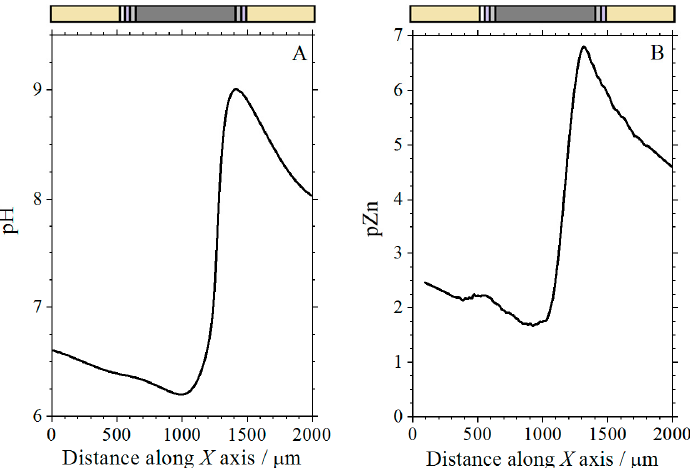
Figure 14. Simultaneous line scans recorded with a double-barrel microelectrode tip containing a pH-sensitive antimony electrode ( A ) and a Zn 2+ -ISME ( B ) above the painted cut edge of galvanized steel (corresponding to sketch #1 in Figure 1C) immersed in 1 mM NaCl